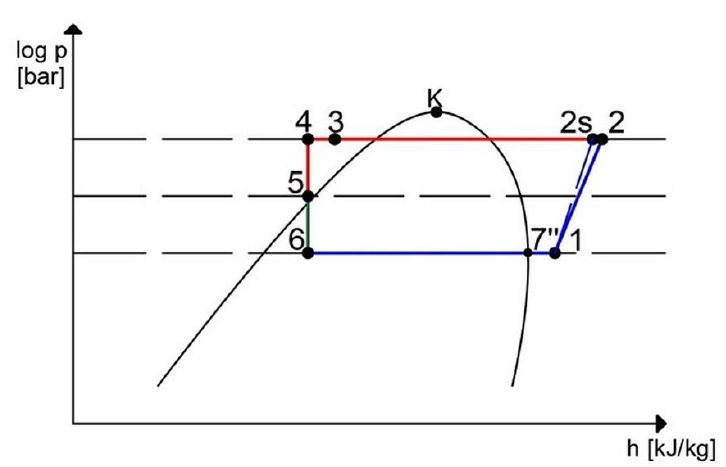
Figure 4. Subcritical carbon dioxide cycle at the beginning of the analysis.